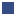
Influence of increasing concentrations of BSA on zeta potential (■) and size (■) of bare (A), amine-functionalised (B), carboxylate-functionalised (C) and aromatic-functionalised (D) silica NPs.